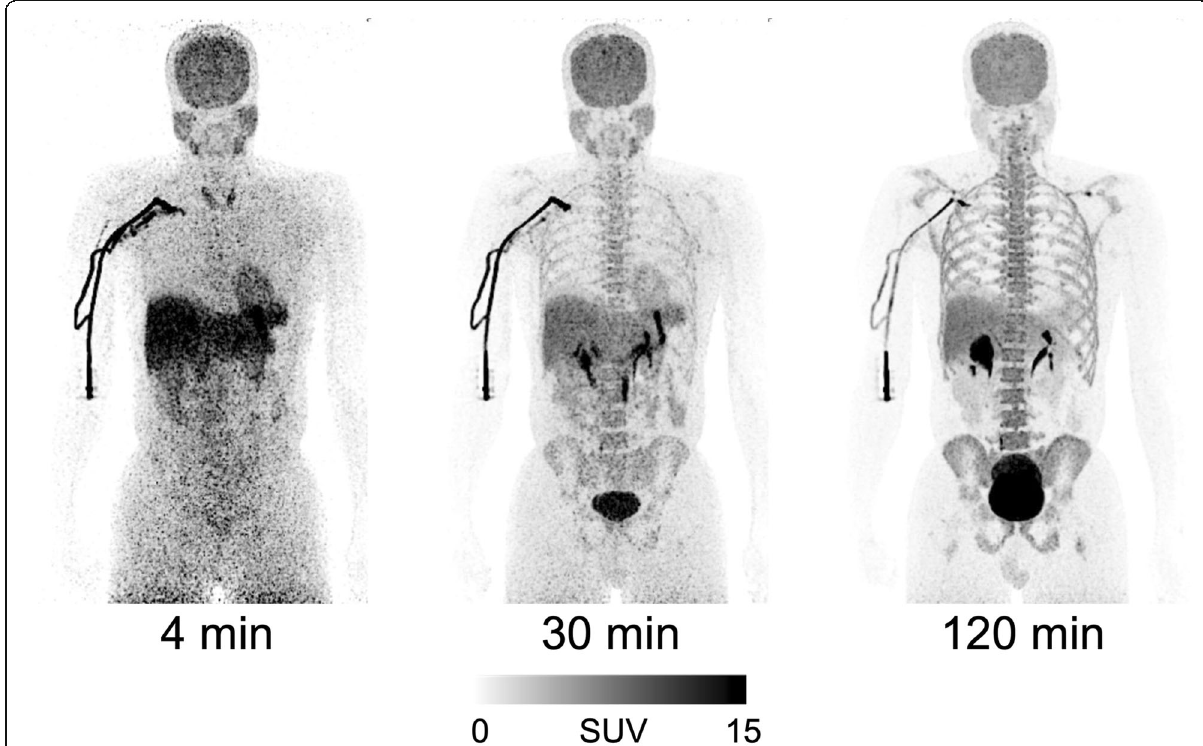
Fig. 7 Whole-body images of a healthy male at 4, 30, and 120 min after [ 18 F]LSN3316612 injection. The images are displayed in standardized uptake value (SUV) as a two-dimensional compression with maximal intensity projected (MIP) forward to emphasize contrast at the edge of organs. The images are decay-corrected to time of